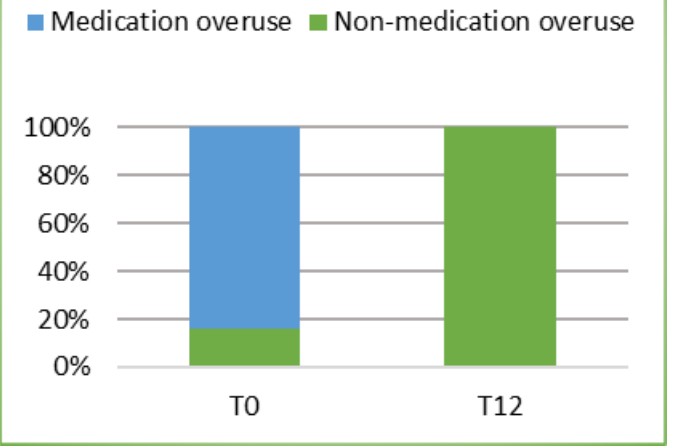
Figure 2. The proportion of patients with medication overuse at baseline who changed status to non–medication overuse.